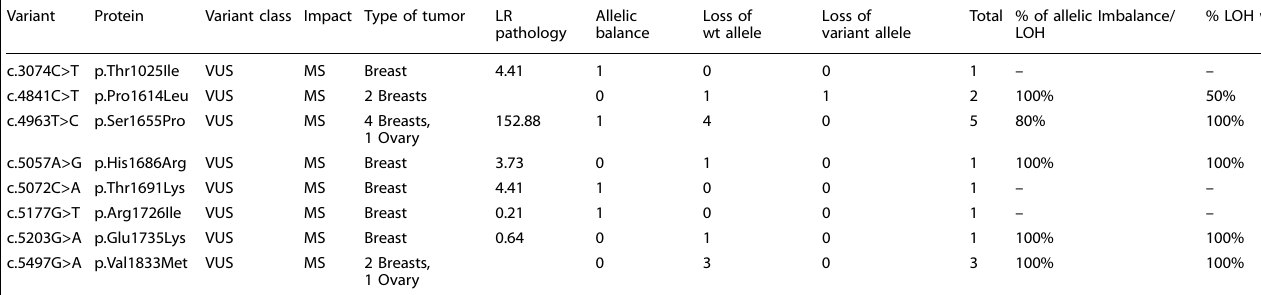
Table 3. LOH results for tumor samples from a variant of uncertain signi fi cance (VUS) carriers.